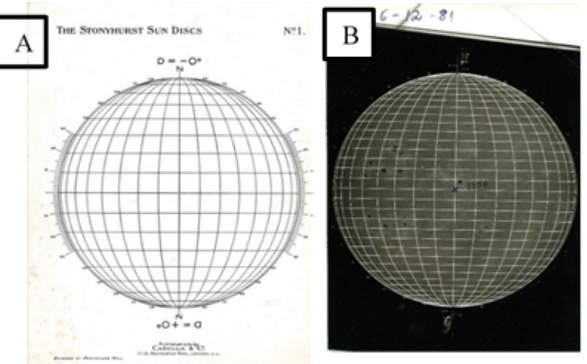
Figure 11. A Stonyhurst disk (A) and a spectroheliogram with the Stonyhurst disk, acquired at the COI on December 6th, 1981 (B) [Source: Geophysical and Astronomical Observatory of the Univer- sity of